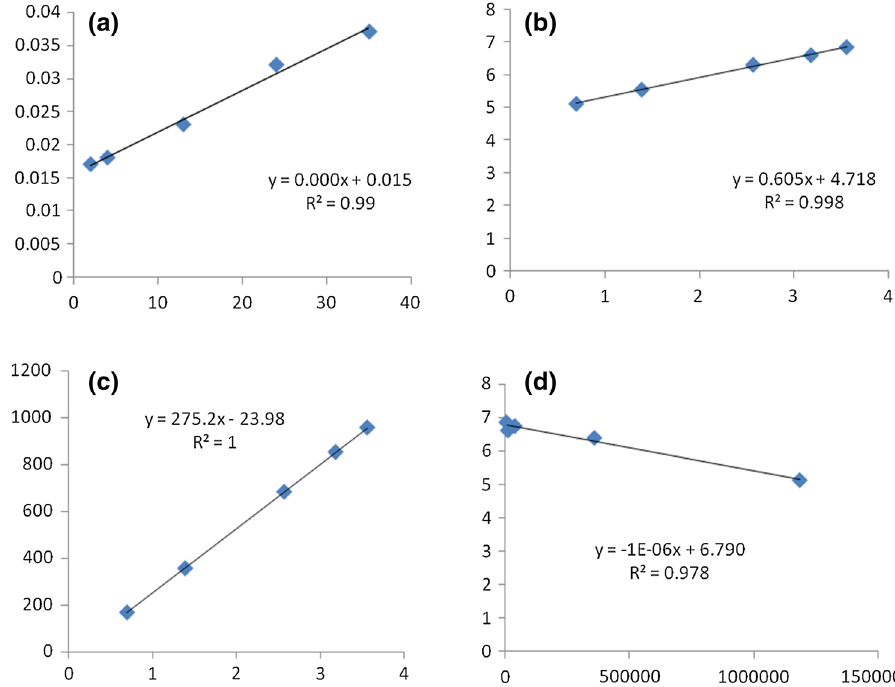
of: a Langmuir, b Freundlich, c Temkin, d DB-R for adsorption at 323 K